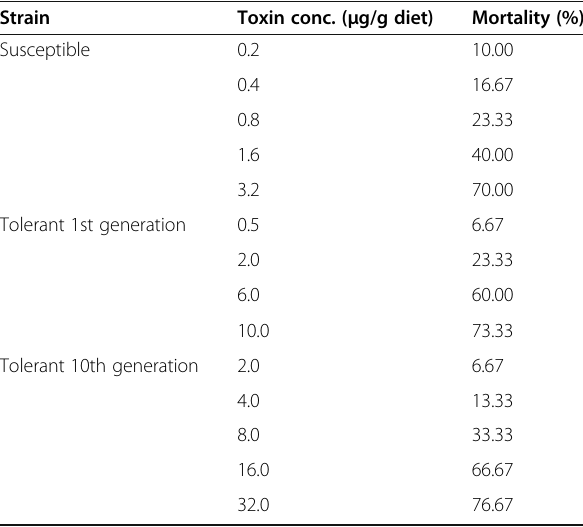
Table 3 Mortality of susceptible and Bt Cry1C — tolerant strains of S. littoralis larvae